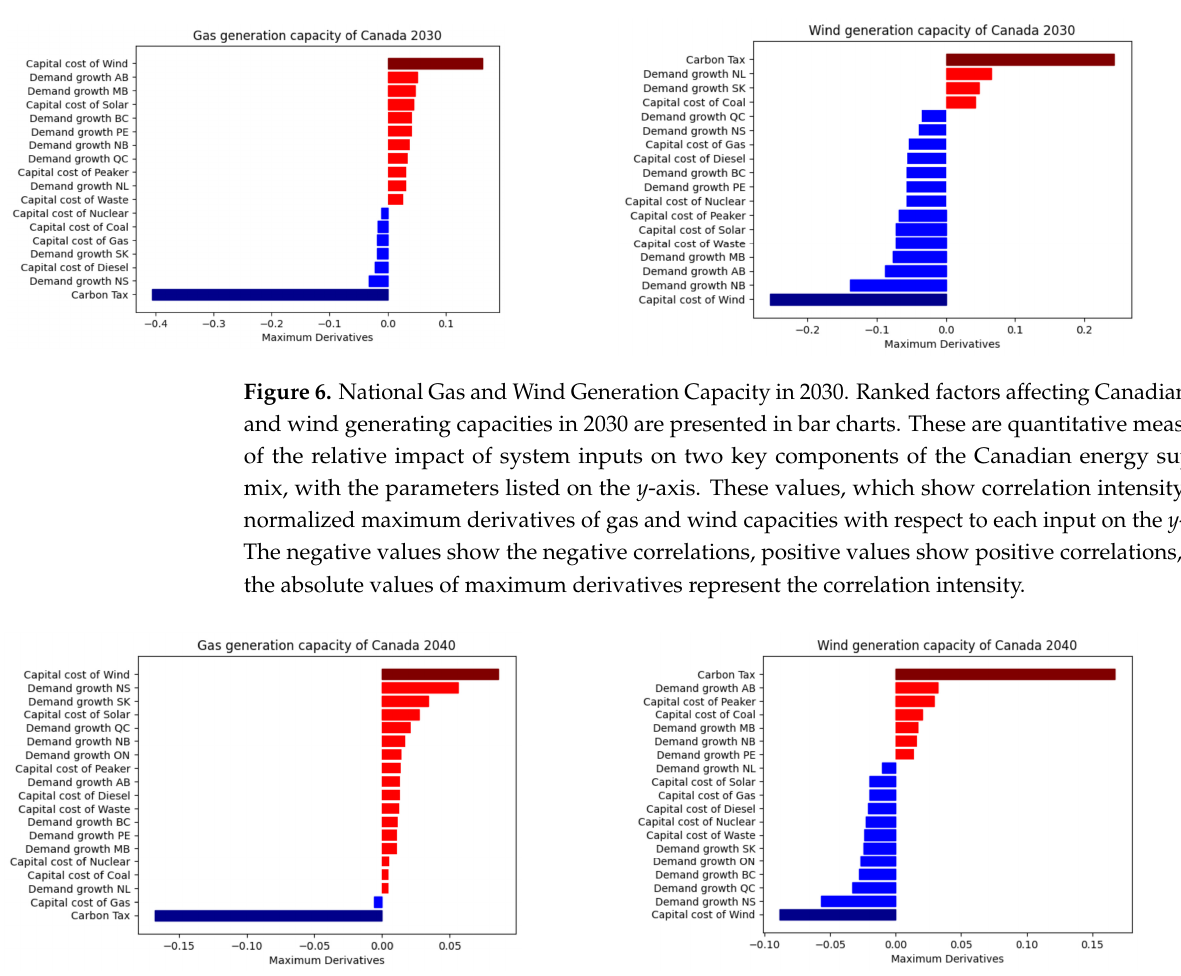
Figure 7. National Gas and Wind Generation Capacity in 2040. Ranked factors affecting Canadian gas and wind generating capacities in 2040 are presented in bar charts. These are quantitative measures of the relative impact of system inputs on two key components of the Canadian energy supply mix, with the parameters listed on the y -axis. These values, which show correlation intensity, are normalized maximum derivatives of gas and wind capacities with respect to each input on the y -axis. The negative values show the negative correlations, positive values show positive correlations, and the absolute values of maximum derivatives represent the correlation intensity.